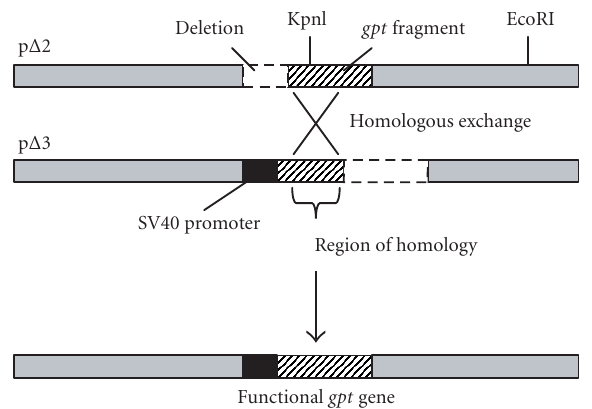
Figure 2. Illustration of integration-associated HR (corresponding to Figure 1b). Plasmid substrates p ∆ 2 and p ∆ 3 contain nonoverlapping 5 (cid:2) and 3 (cid:2) deletions, respectively. There is an area of shared homology of approx- imately 400 bp. Experiments were carried out with cleavage at a distance from the gene, that is, EcoRI, or within the gene, that is, KpnI. See [18] for details. Homology-mediated recombination and gpt gene restoration can occur before, during, or shortly after chromosomal plasmid integration. Cellular resistance to XHATM is selected for after